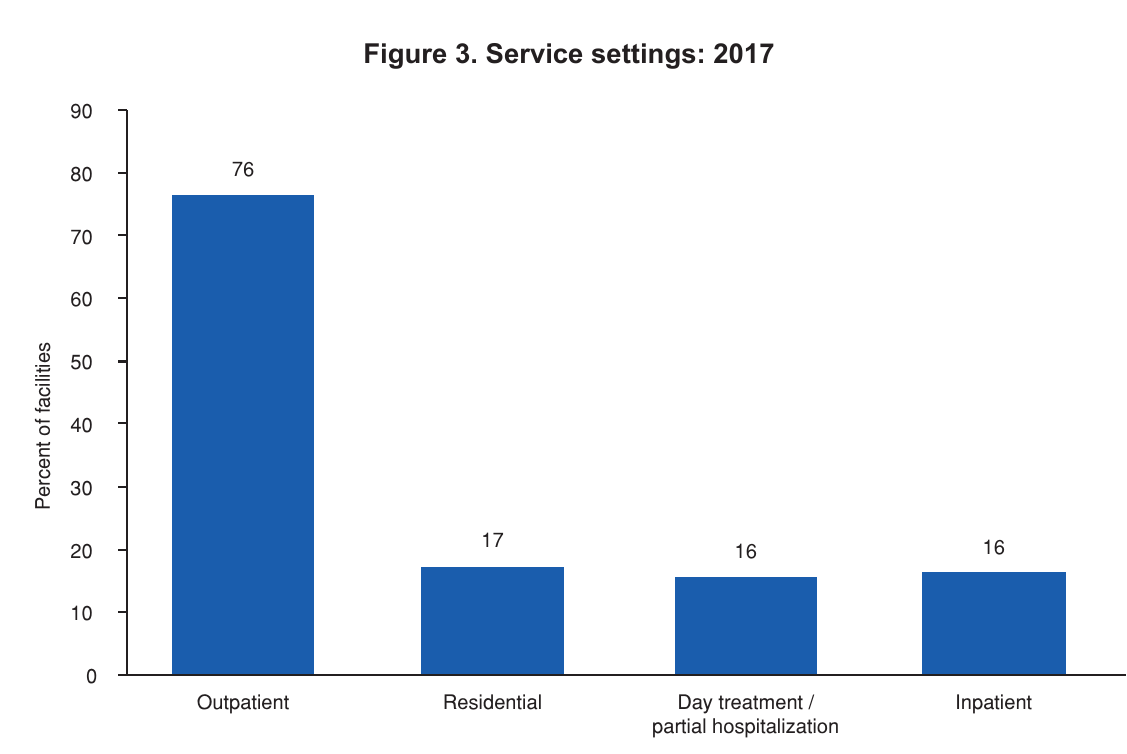
Figure 3. Service settings: